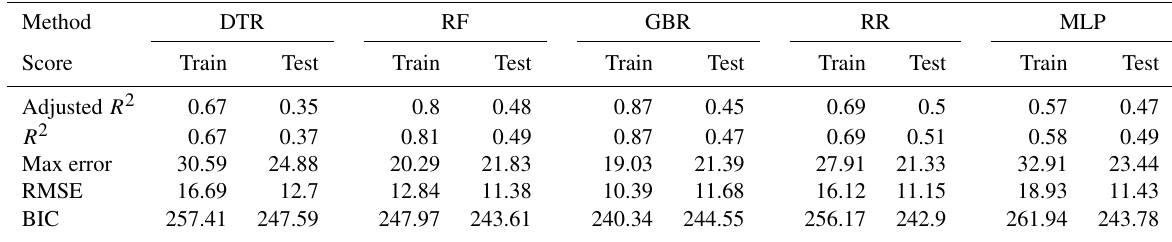
Table A2. Training and test scores on annual basis for the urban population. Method